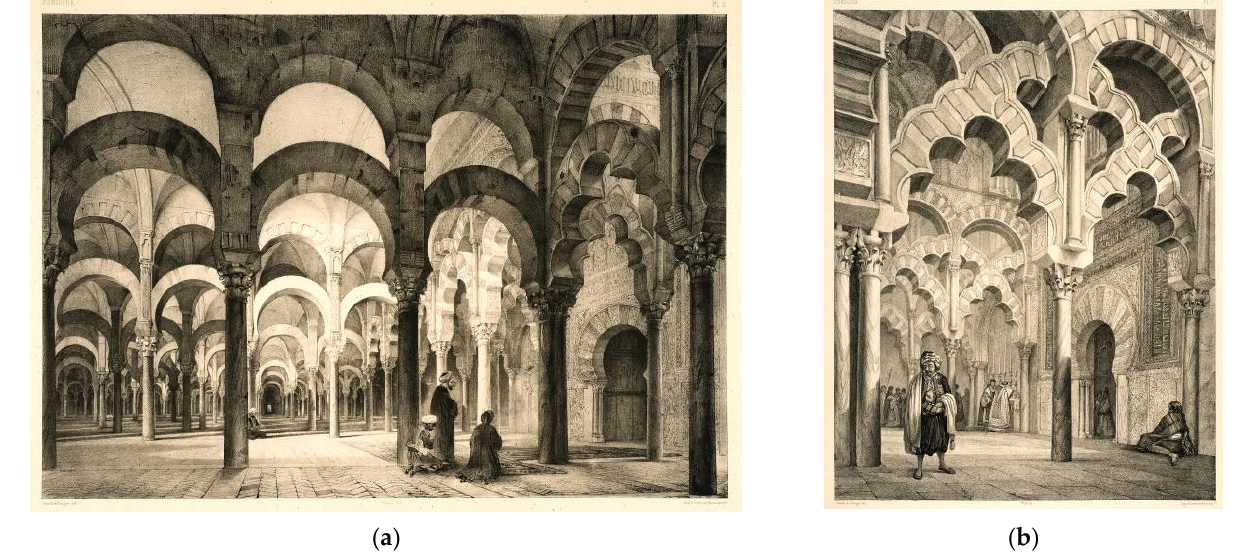
Figure 6. Mosque-Cathedral of Cordoba views: ( a ) The Guadalquivir river, the Roman bridge and the town (Bichebois, lit.; Bayot, fig.) ( b ) Lateral entrance facade (Wyld, lit.). Source: Monuments arabes et moresques de Cordoue, 1839.